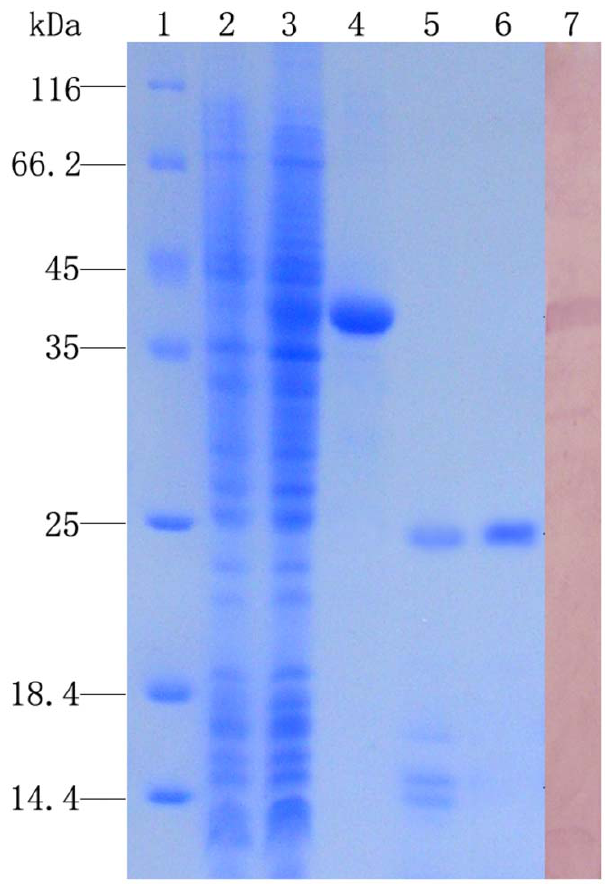
Figure 2. SDS-PAGE and Western-blot analysis of rCfLec-1. Lane 1: protein molecular standard; lane 2: negative control for rCfLec-1 (without induction); lane 3: induced rCfLec-1; lane 4: purified rCfLec-1; lane 5: production of rCfLec-1 digested by enterokinase; lane 6: rCfLec-1 with out Trx tag; lane 7: western-blot of rCfLec-1.